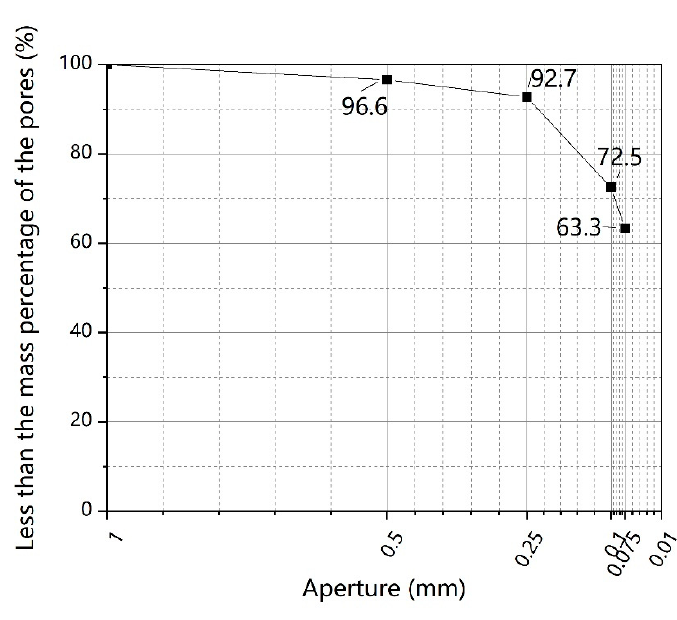
Figure 1. Gradation curve of undisturbed soil. Table 2. Main chemical components of tested soil (expressed as oxides). Table 1. Basic physical properties of undisturbed soil samples.